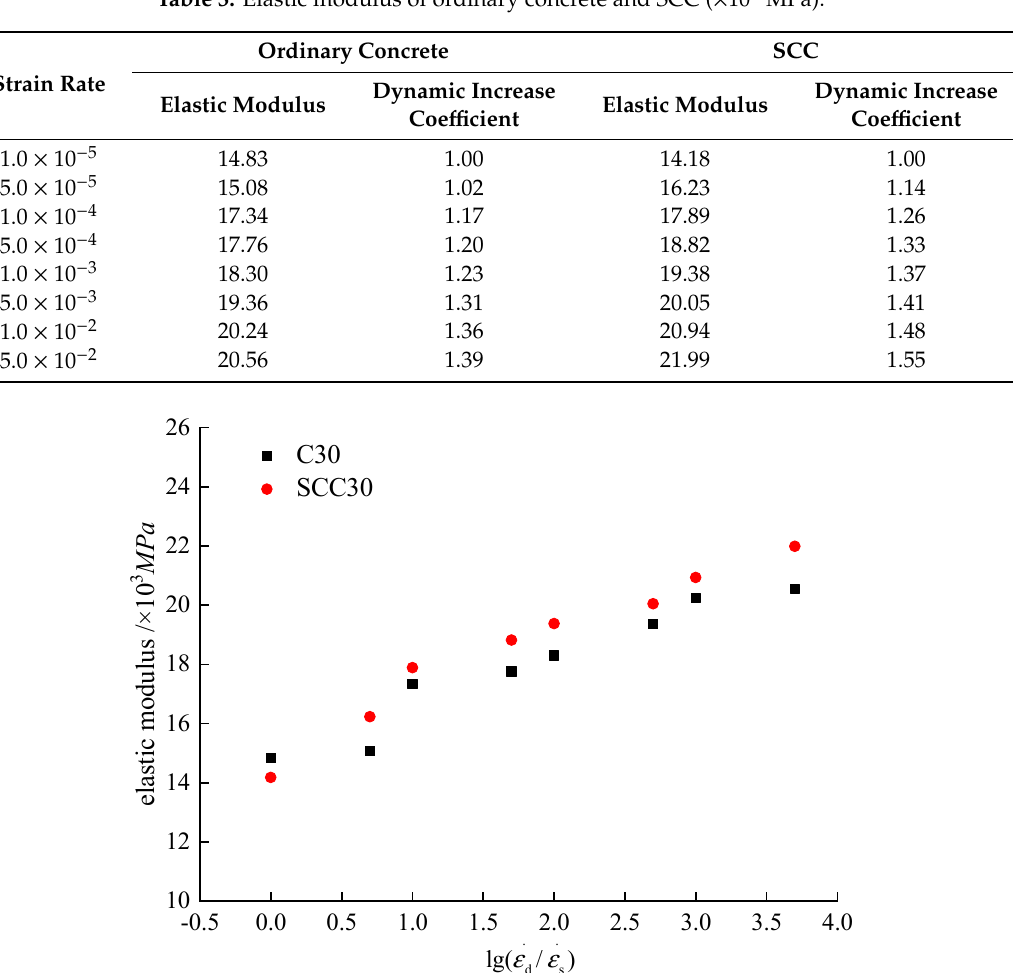
Table 3. Elastic modulus of ordinary concrete and SCC (×10 3 MPa).